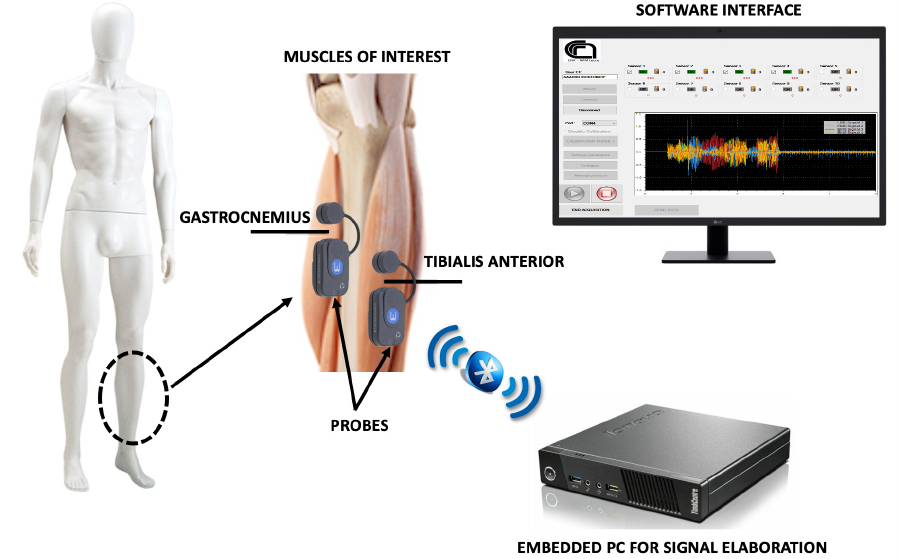
Figure 1. Schematic overview of the proposed sEMG